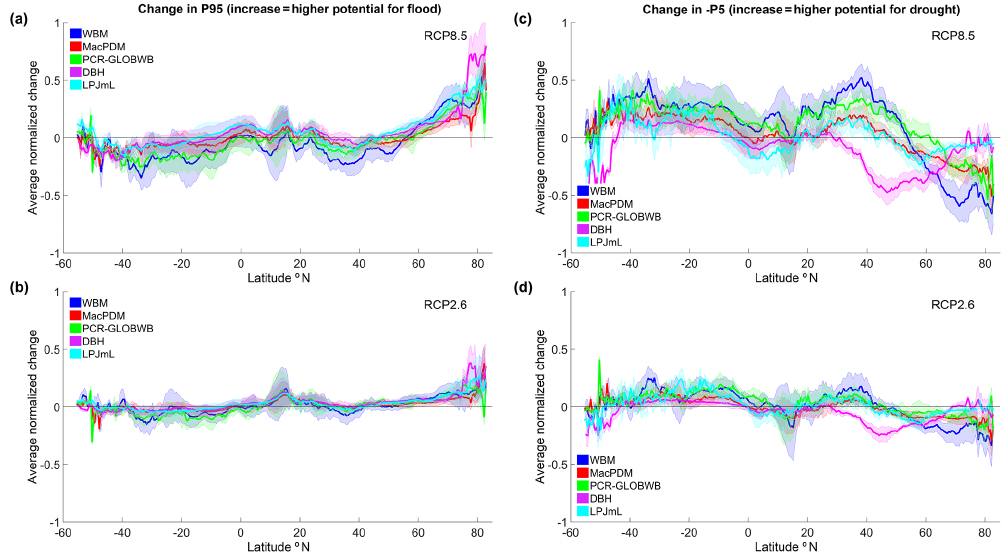
Figure 3. Multi-model change in P95 under the RCP8.5 (a) and RCP2.6 (b) scenarios, and change in P5*–1 under the RCP8.5 (c) and RCP2.6 (d) scenarios, averaged by latitude. The thick lines in the plots show the mean change in the indicator, based on the streamflow routings of each GHM based on inputs from multiple GCMs, and the shading denotes ± 1 SD.